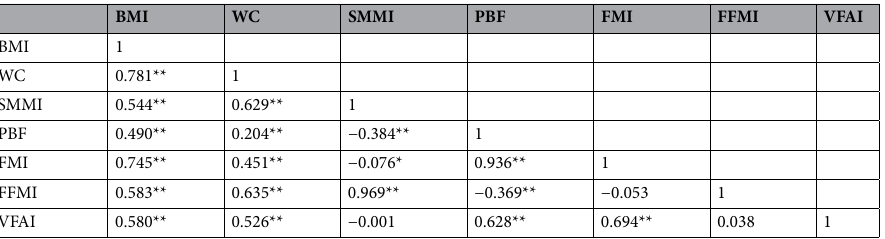
Table 2. Pearson’s correlation coefficients for the body composition indices. BMI: body mass index; WC: waist circumference; SMMI: skeletal muscle mass index; PBF: percent body fat; FMI: fat mass index; FFMI: fat free mass index; VFAI: visceral fat area index; shaded numbers indicate a significant negative correlation. *: p < .05; **: p < .001.